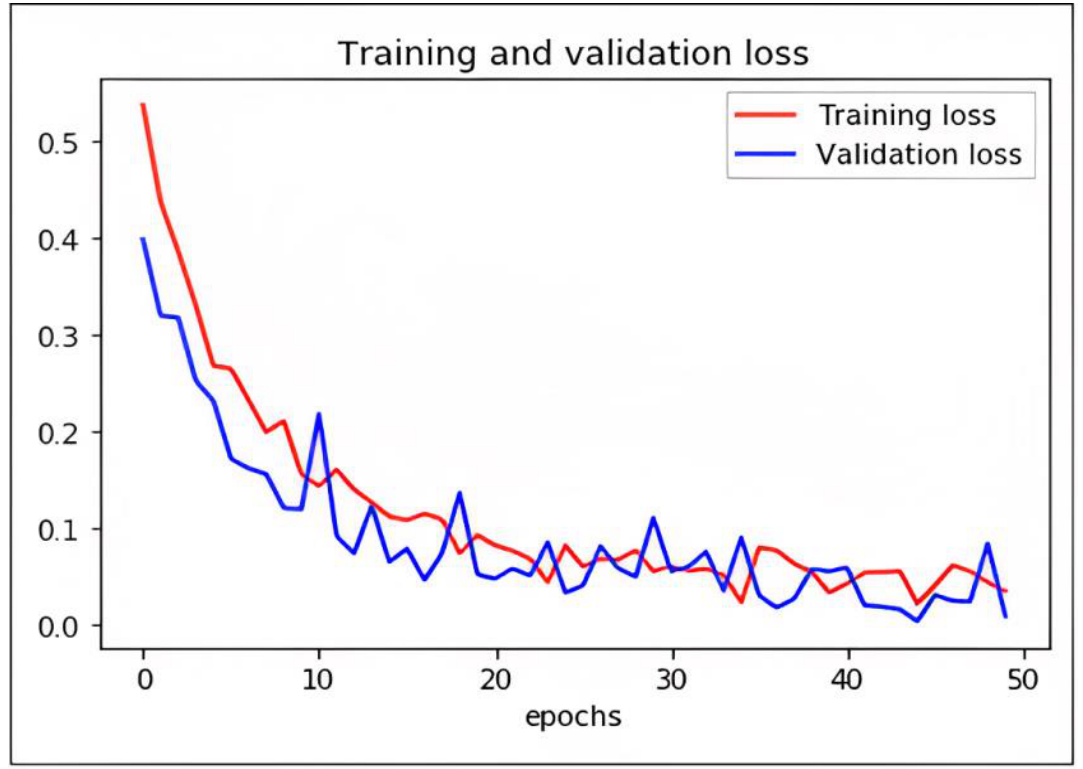
Figure 9. Graph plot representing loss with epochs of DCAE + ESD-Bi-LSTM.